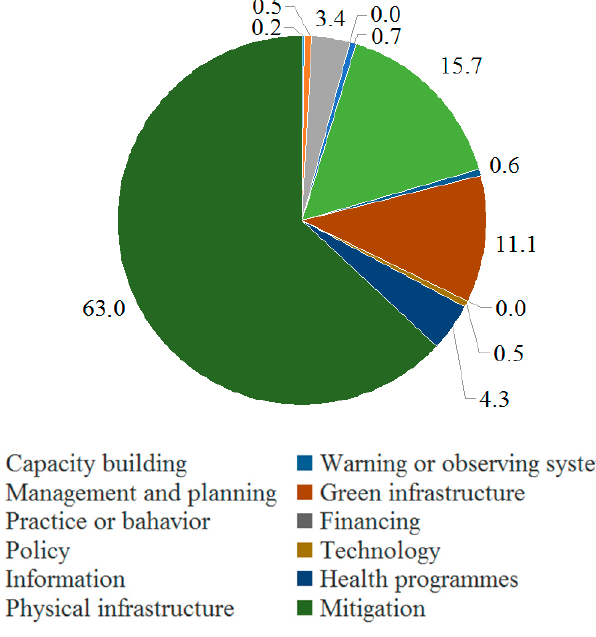
Figure 3. Share of the expenditure planned for individual types of measures (in %) in the total spending on adaptation actions in the MAPs of selected cities in Poland up to